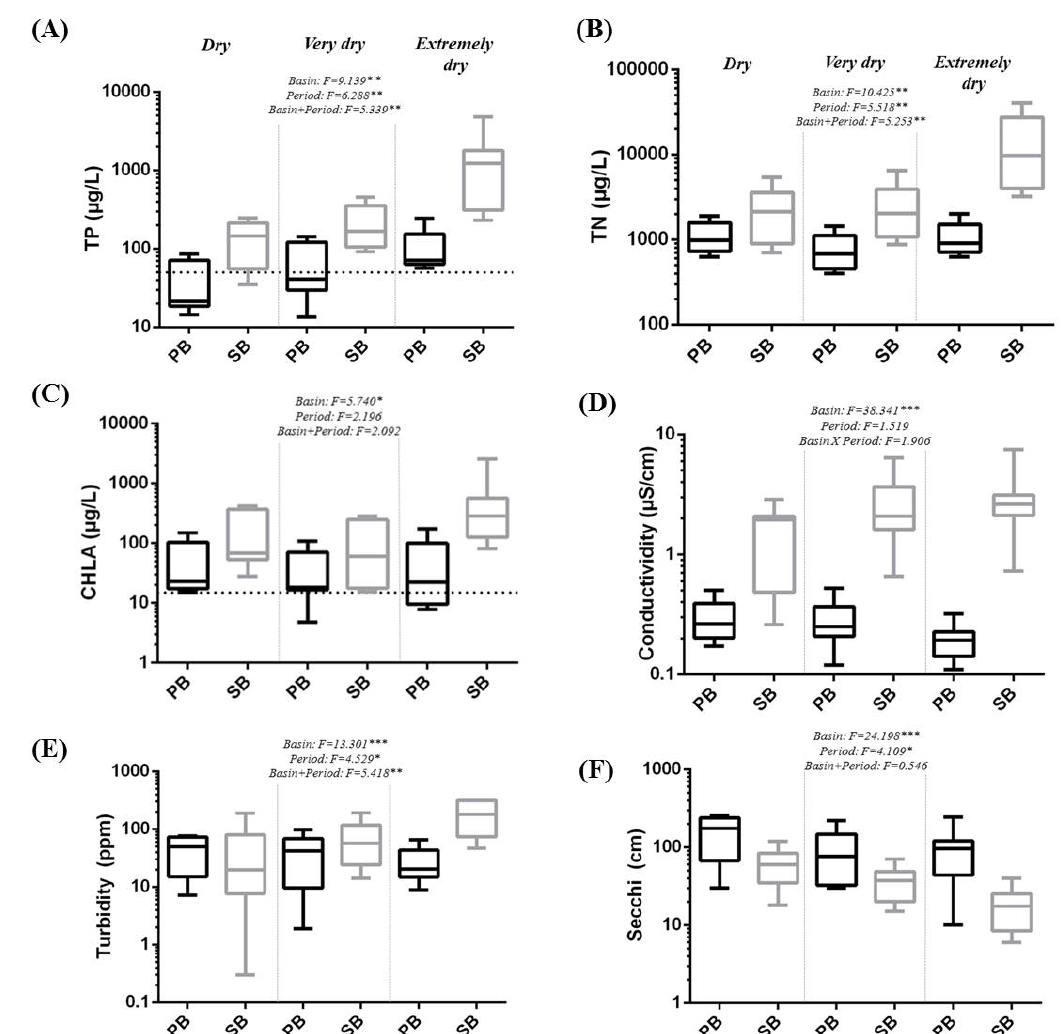
Figure 3. Results of two-way ANOVA for testing the periods (dry, very dry and extremely dry), basins (PB and SB) and their interaction effects on total phosphorus (A), total nitrogen (B), chlorophyll-a (C), conductivity (D), turbidity (E) and Secchi depth (F). The trophic level classification (Mesotrophic – TP < 50 μg/L, CHLA < 15 μg/L; Eutrophic – TP > 50 μg/L, CHLA > 15 μg/L) was based on Thornton & Rast (1993). The y-axes are in logarithmic scale. Bands inside the boxplots represent their medians and vertical bars represent minimum and maximum values. PB – Piancó basin; SB – Seridó basin. The asterisks symbols denote: *p ≤ 0.05, **p ≤ 0.01 and ***p ≤